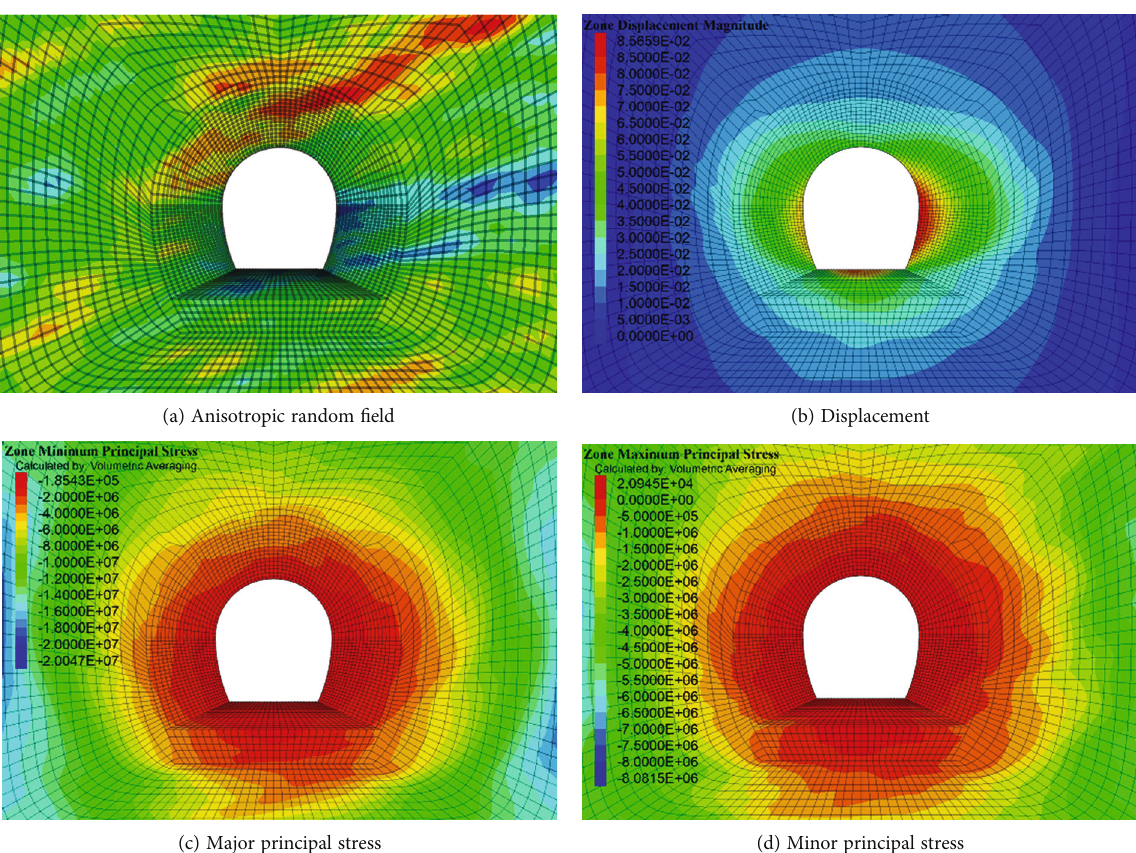
Figure 10: Analysis of cavern excavation results with 15 ° anisotropic fi